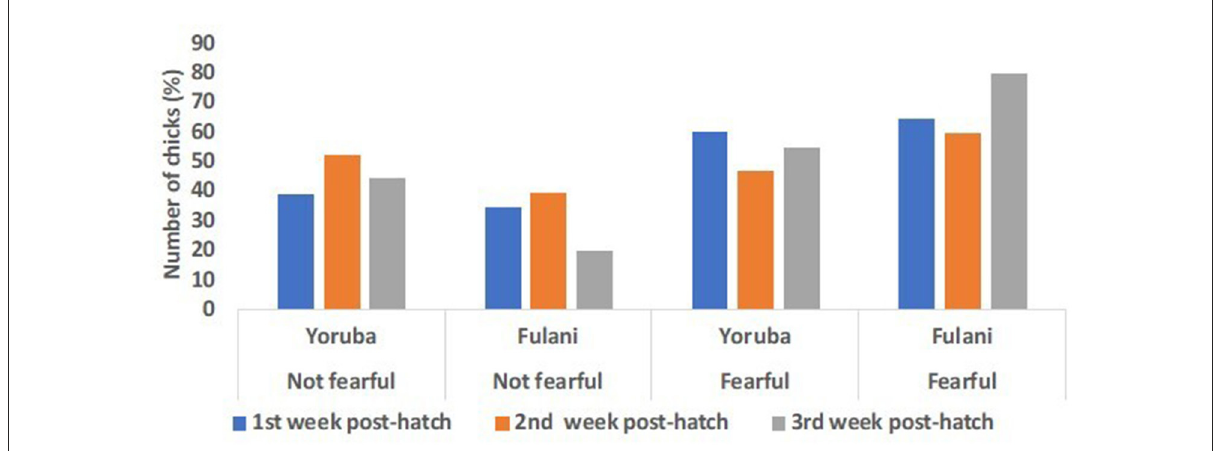
FIGURE11 Predator fear score responses in two ecotypes (1 = Yoruba and 2 = Fulani) of Nigerian indigenous chicks at weeks 1–3 (i.e., day 8 (blue bars), day 15 (orange bars), and day 22 (gray bars)